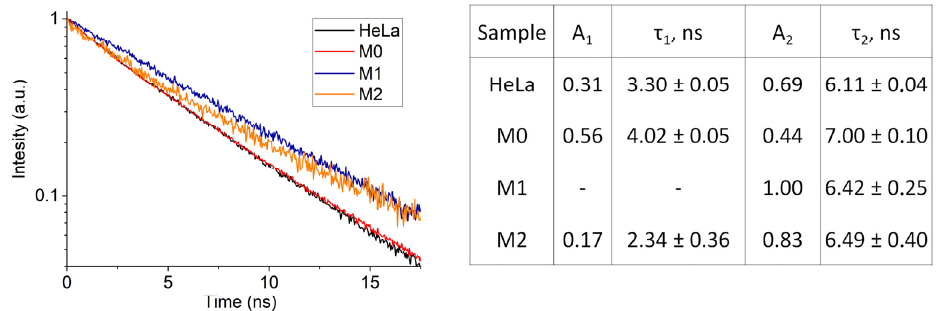
Figure 5. Fluorescence images of M0, M1 and M2 macrophages after 24 h of incubation with AlPc NP colloids. AlPc NP fluorescence is red.